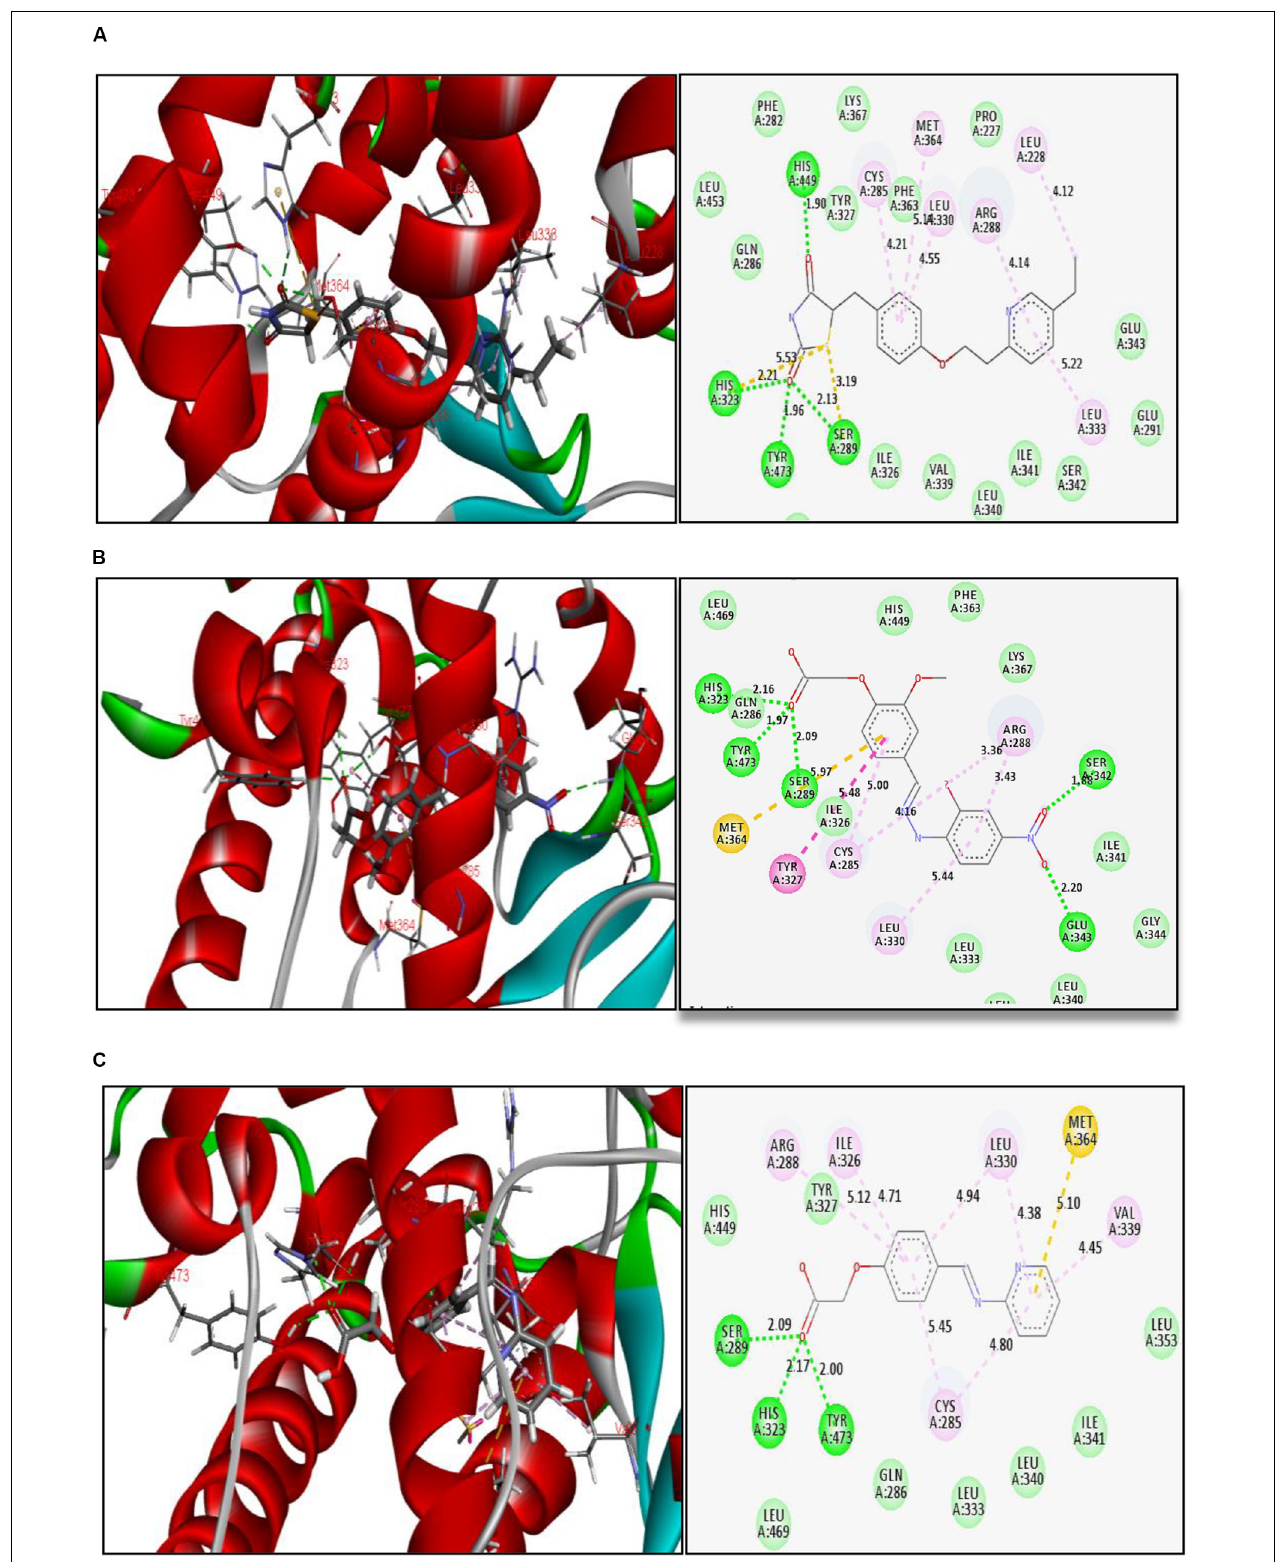
FIGURE 2 | Binding interactions of (A) reference ligand pioglitazone, (B) glitazone 1 (G1), and (C) glitazone 2 (G2) at the active site of PPAR- γ , with green lines indicating strong H-bond, yellow lines indicating (cid:53) –sulfur bonds, and purple lines indicating hydrophobic interactions.